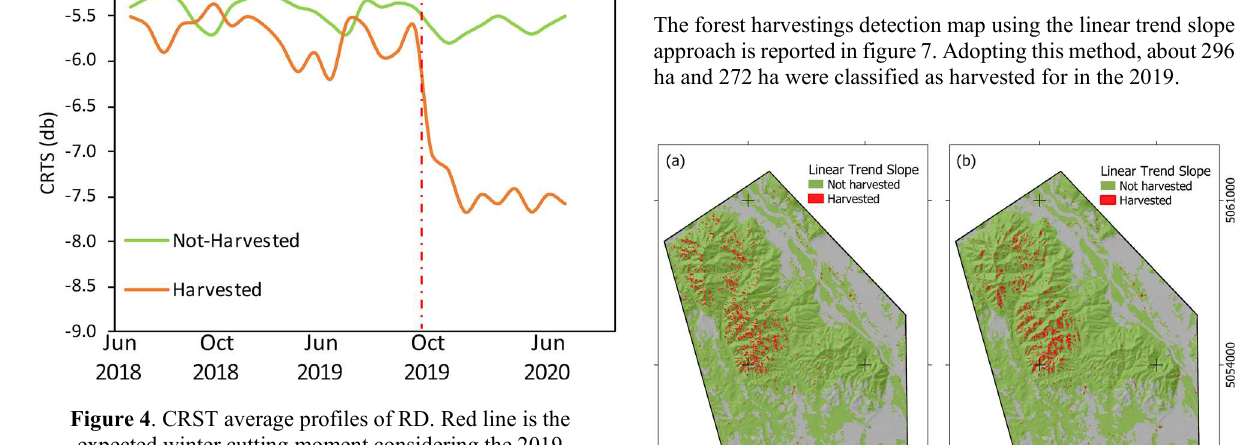
Figure 6 . Forest harvestings classification by Residuals CUSUM method for (a) ascending CRTS and (b) for descending CRTS. Reference frame is WGS84 UTM